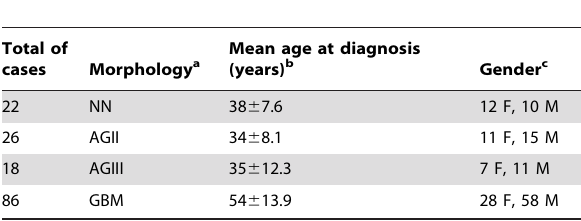
Table 1. Demographic data from patients analyzed in this